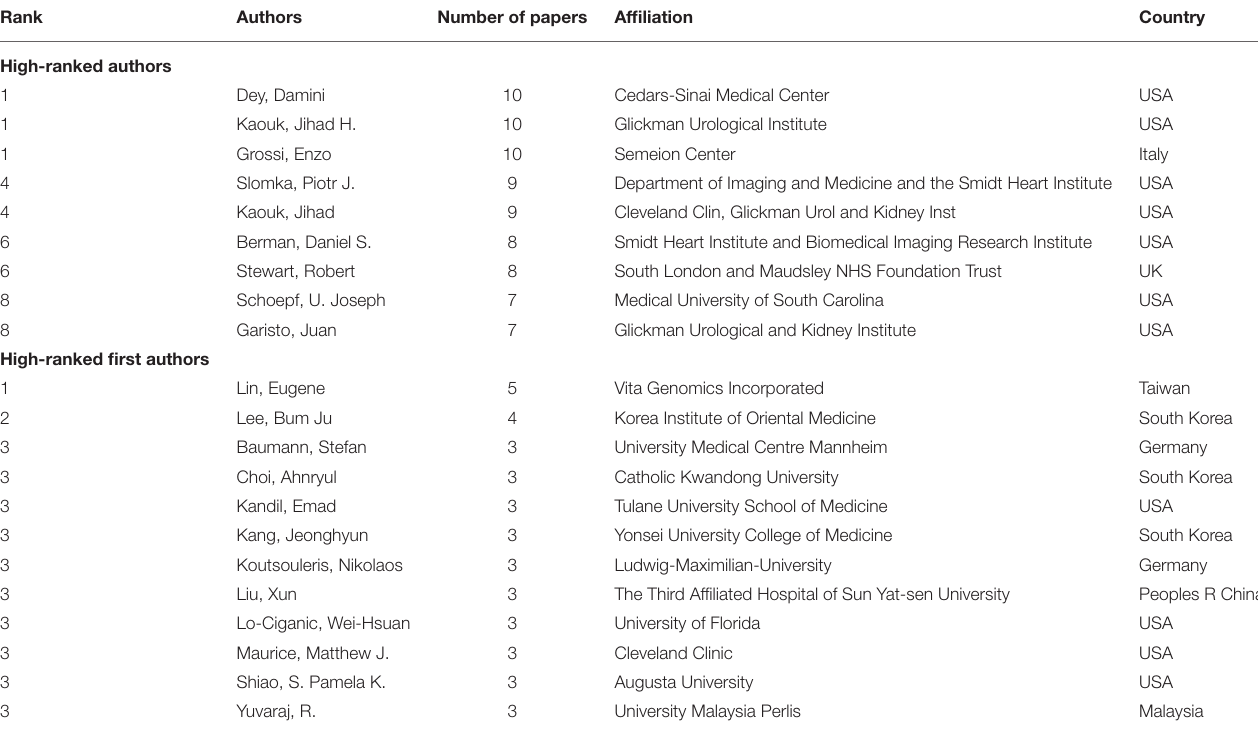
TABLE 3 | The authors and first-authors contributing the most gender-related articles in medical artificial intelligence. Rank